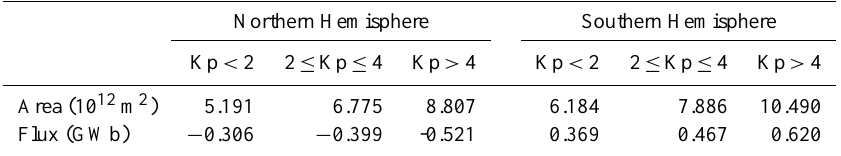
Table 3. The polar cap area and estimated open magnetic flux in the two